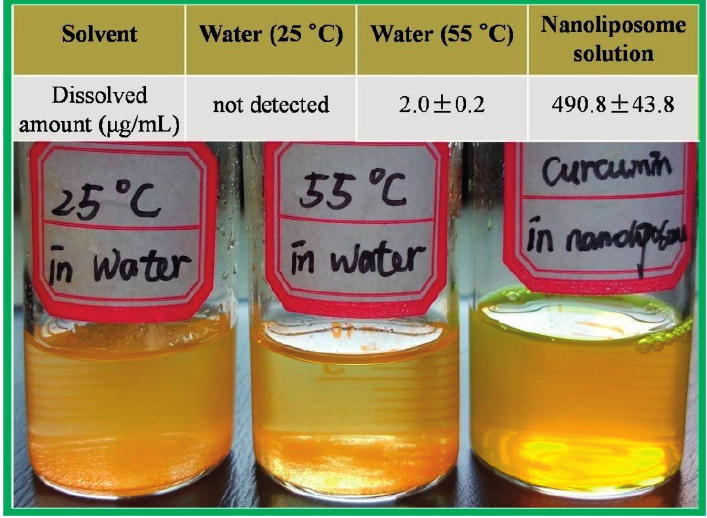
Figure 1. Curcumin dispersed in three